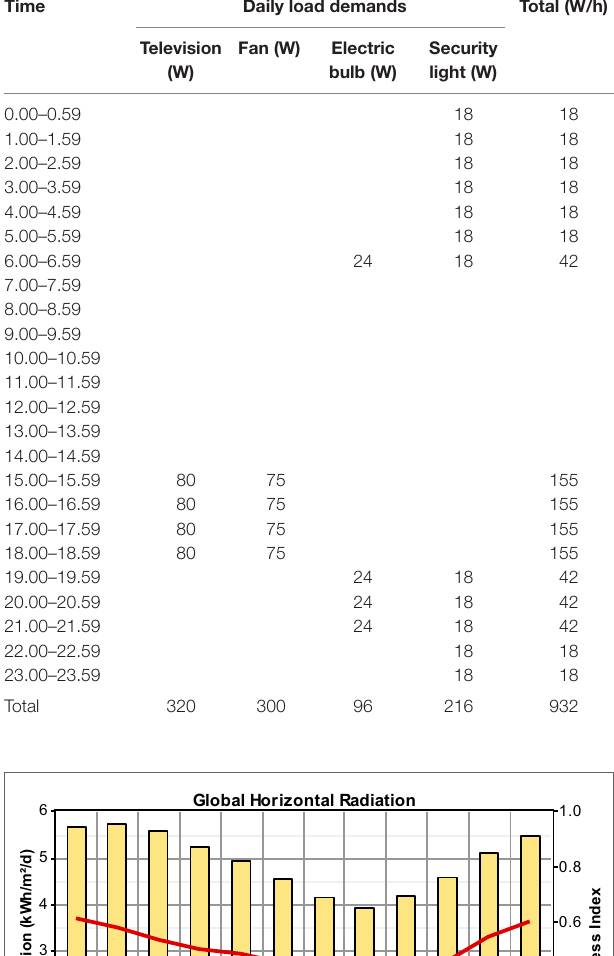
TaBle 2 | The electrical load (daily load demands) data for the